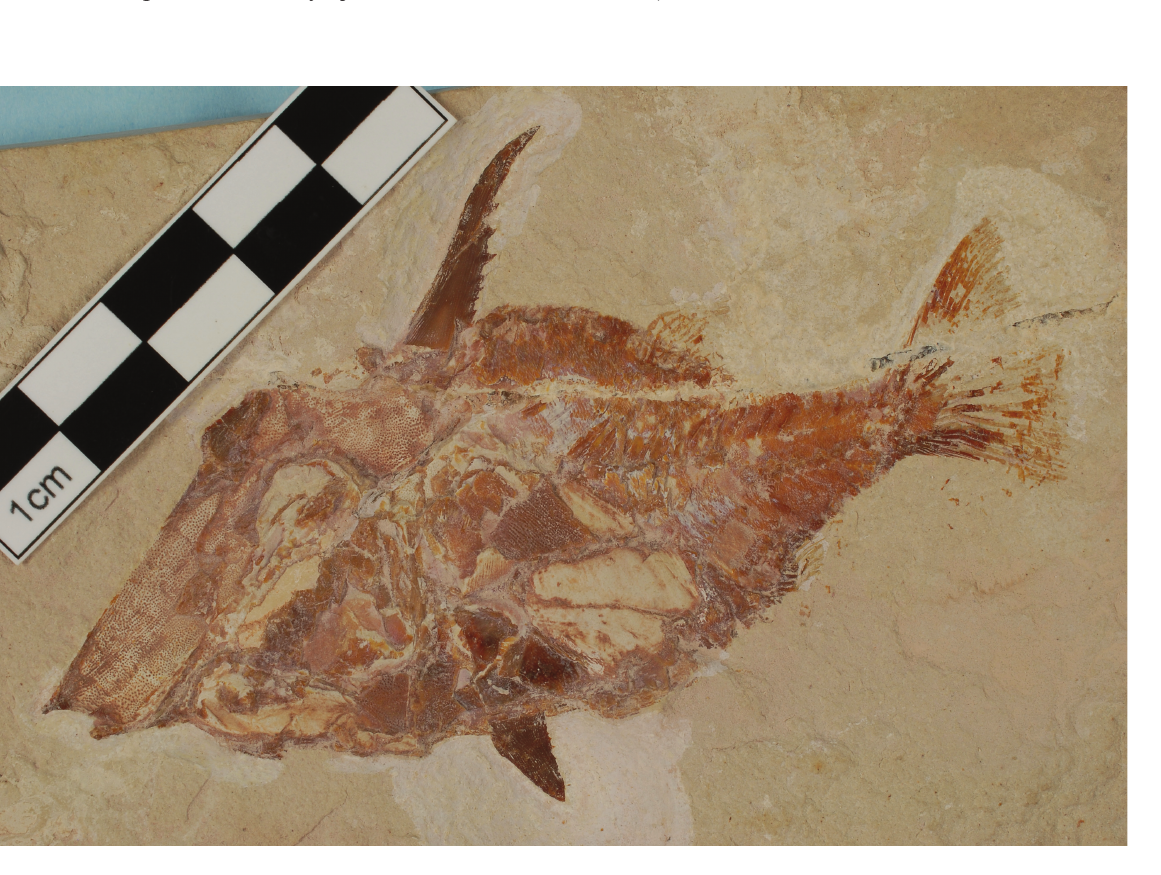
Formation and locality Marine Upper Cenomanian, Haqel and Hgula, Lebanon.